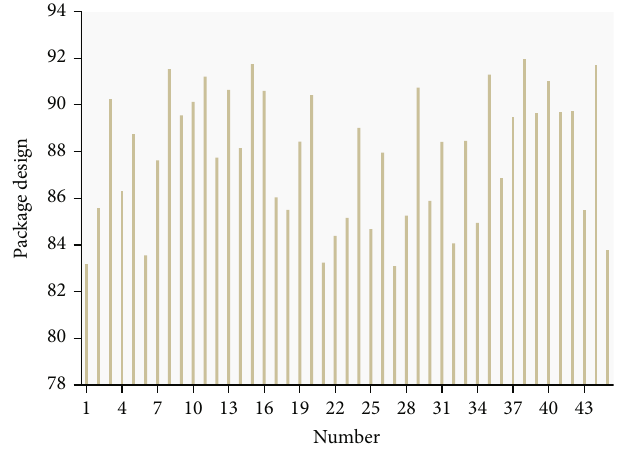
Figure 8: Visual diagram of test